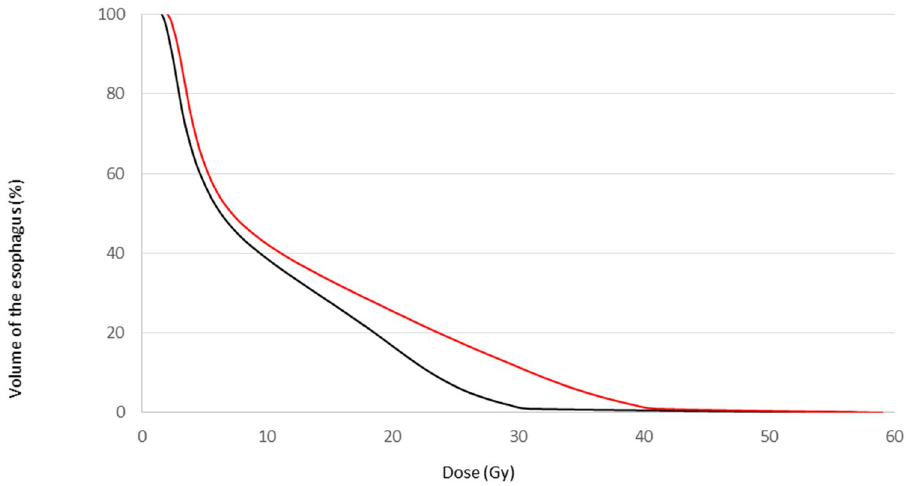
Figure 1. The mean dose-volume histogram for the esophagus for patients without esophageal toxicity (black line) and patients with grade ≥ 1 acute esophageal adverse events (red